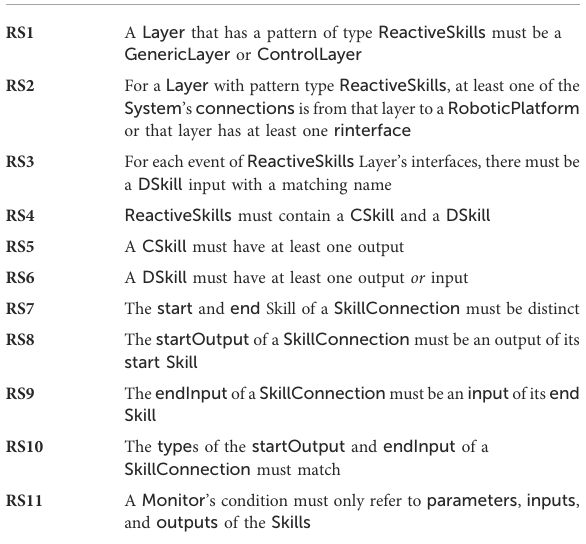
TABLE 5 The well-formedness conditions of reactive-skills designs. Condition